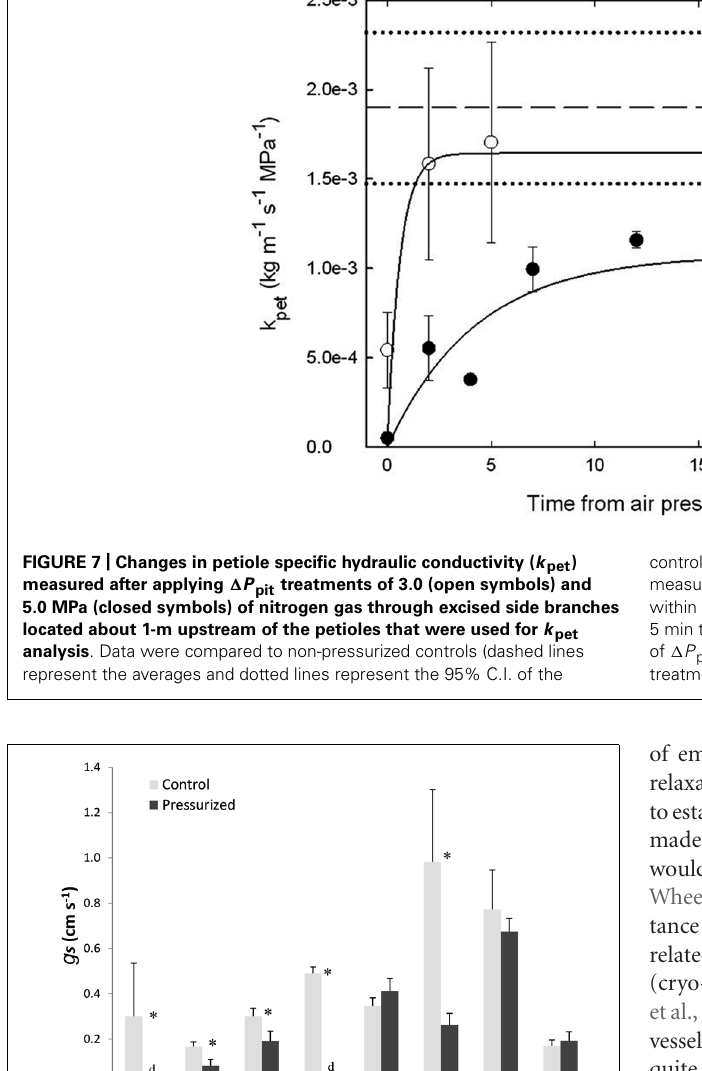
FIGURE 8 |A survey of plant tolerance to pneumatic pressurization treatments . All plants were pressurized with 5.5 MPa of gas pressure for 2 min. Repeated measures of stomatal conductance were measured for 10 min before air-pressurization treatments and then the following day. All measurements were made at the same time of the day before and after air-pressurization. Asterisks represent leaves that were wilted the following day. Both days were similar in abiotic conditions (e.g., both days were sunny). For all species, stomatal conductance was also measured on leaves from branches before and 24 h after being excised from the parent tree. Leaves from all excised branches had zero-stomatal conductance (data not